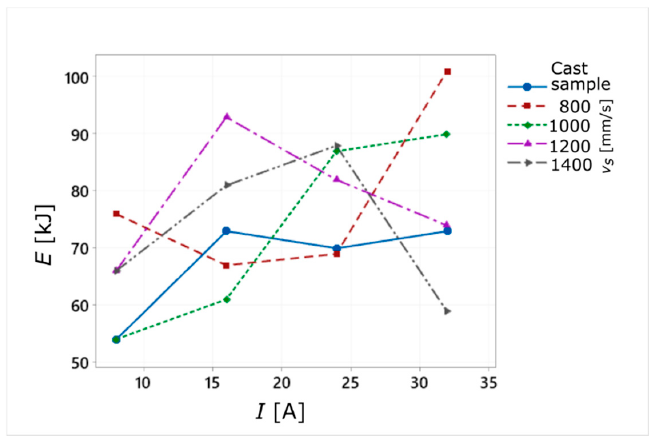
Figure 5. The average values of the total process energy consumption for sintered and cast samples.